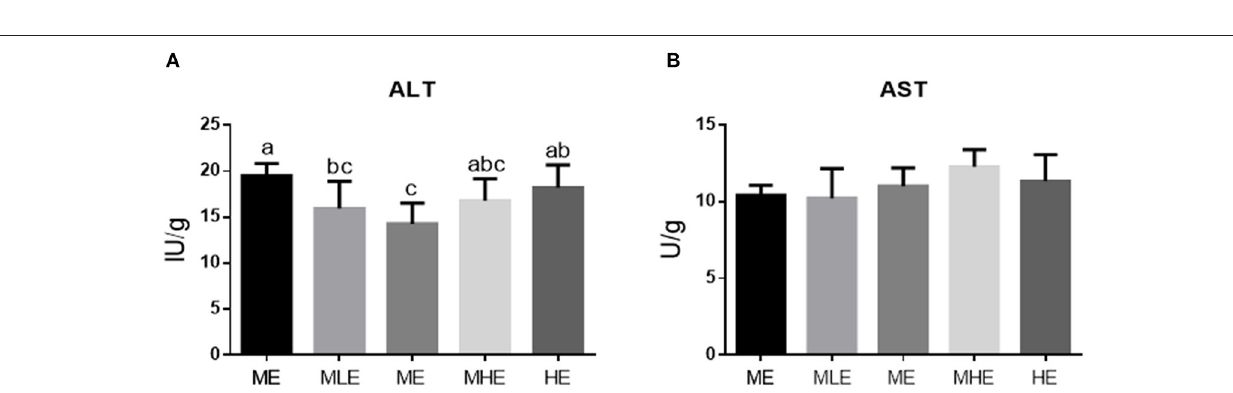
FIGURE 2 | The effects of dietary energy level on transaminase enzyme activity of Yunnan semi-fine wool sheep. The result of ALT (A) . The result of AST (B) . Values with different letters were significantly different ( p < 0.05).